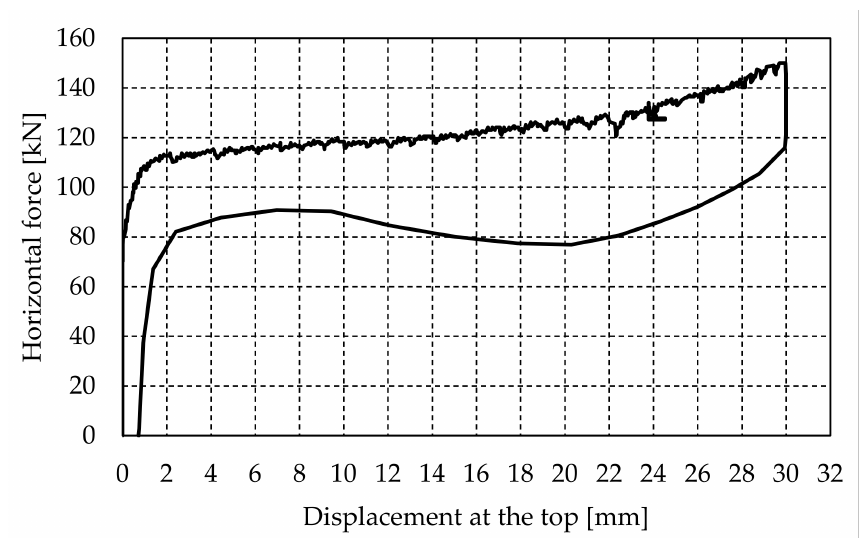
Figure 19. Pushover curve for W3 (V = 230 kN, σ v = 0.4 N/mm 2